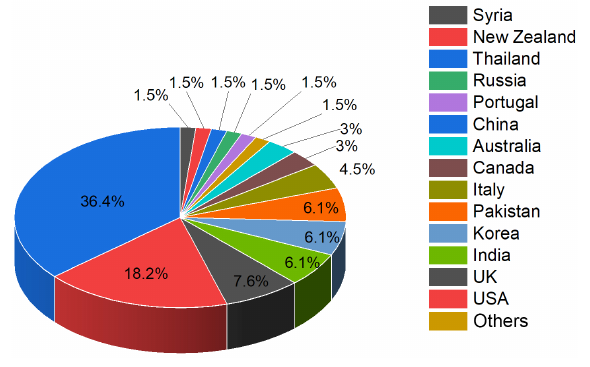
Fig. 8 Publication origin distribution.